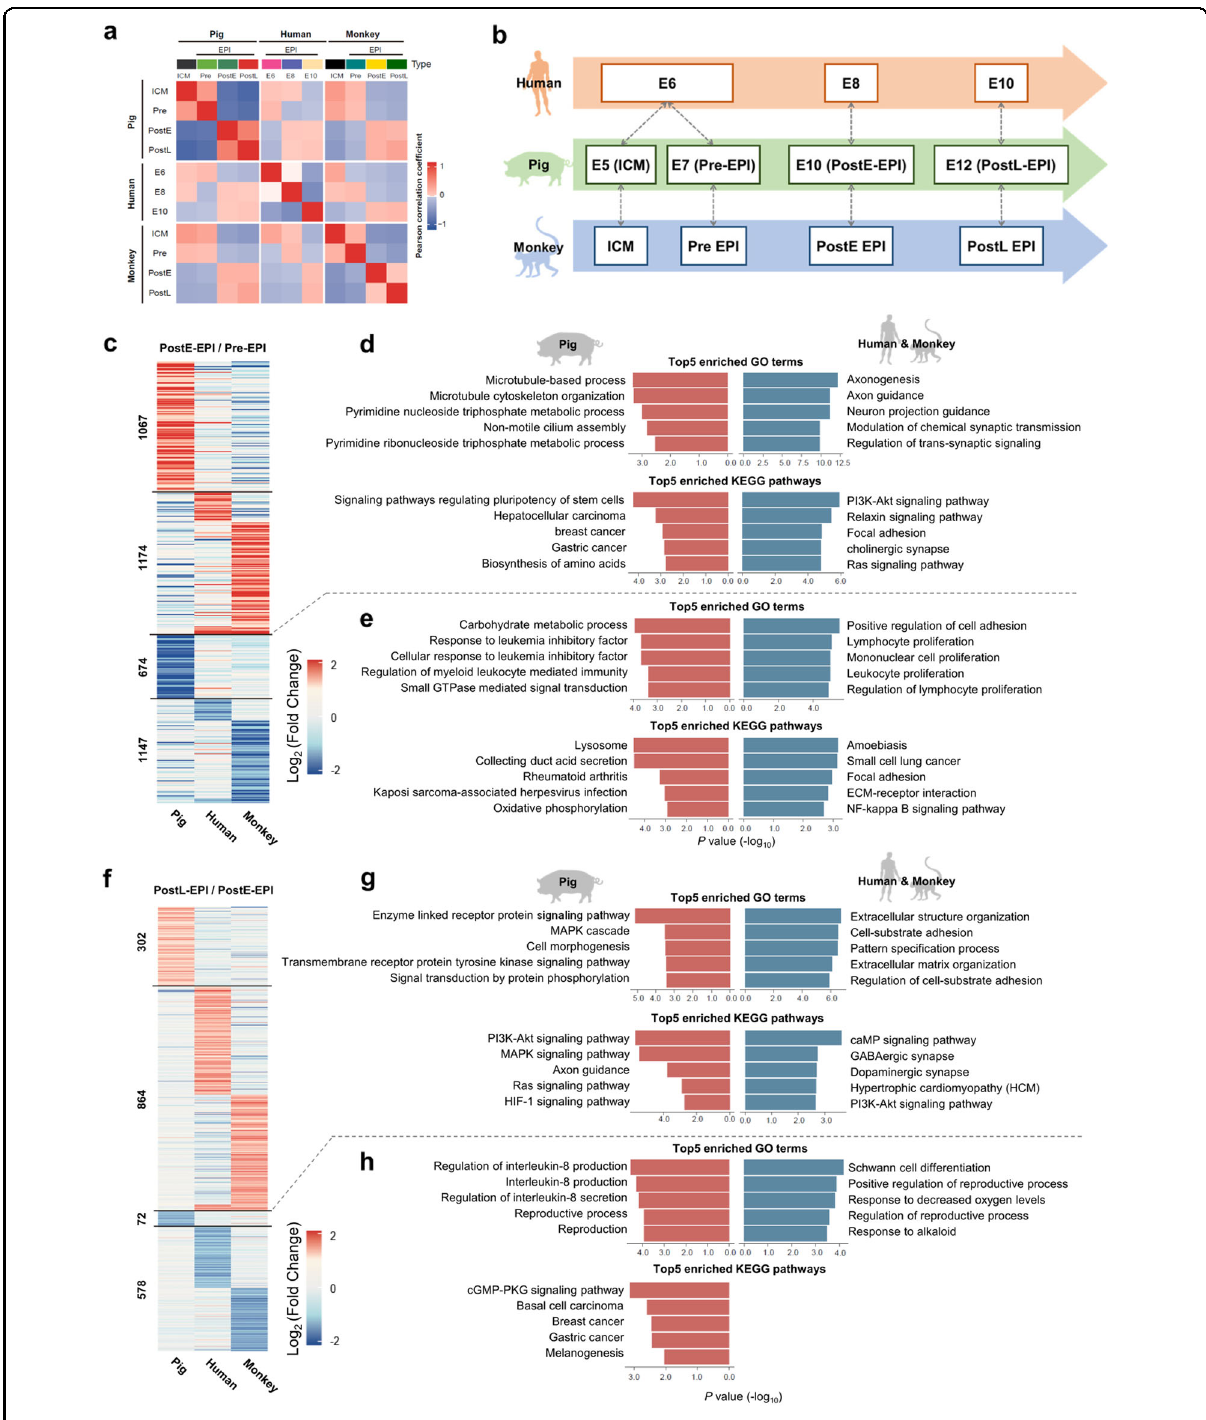
Fig. 3 Cross-species comparison of EPI development and pluripotency progression. a Heatmap of the correlation coef fi cients among EPIs. b Schematic diagram showing developmental coordinate of the spectrum of human, monkey and pig pluripotency. c Heatmap of DEGs of Pre- and PostE-EPIs in pigs, humans, and monkeys. d Top 5 enriched GO terms and KEGG pathways of upregulated DEGs of Pre- and PostE-EPIs in each species. e Top 5 enriched GO terms and KEGG pathways of downregulated DEGs of Pre- and PostE-EPIs in each species. f Heatmap of DEGs of PostE- and PostL-EPIs in pigs, humans, and monkeys. g Top 5 enriched GO terms and KEGG pathways in upregulated DEGs of PostE- and PostL-EPIs in each species. h Top 5 enriched GO terms and KEGG pathways in downregulated DEGs of PostE- and PostL-EPIs in each species. Stage information was indicated as follows: Pre-, Day 5 or/and Day 7; PreE-, Day 5; PreL-, Day 7; Post-, Day 10 and Day 12; PostE-, Day 10; PostL-, Day